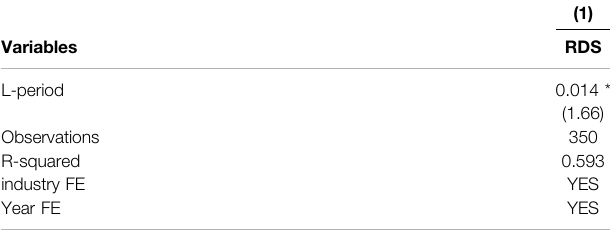
TABLE 12 | Regression results of late intervention on R&D investment